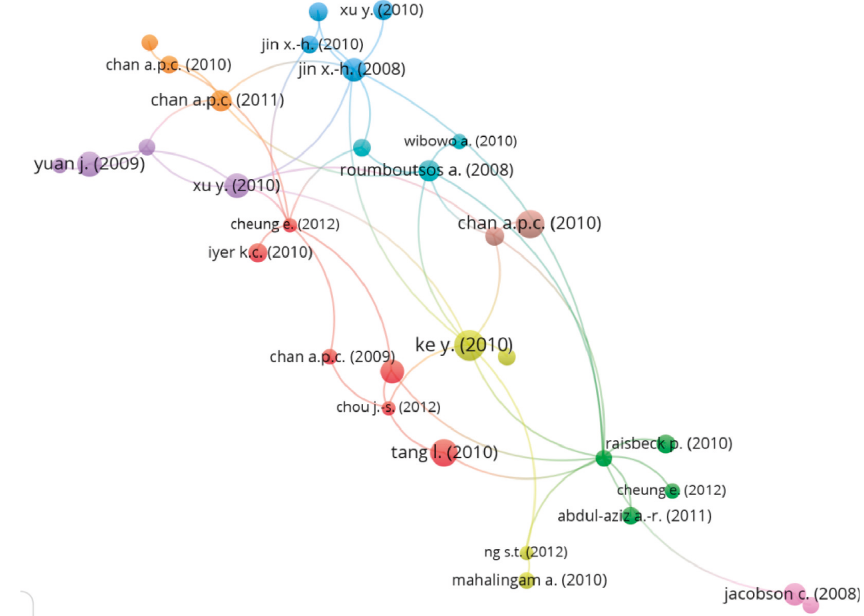
Figure 6: Science mapping of PPP